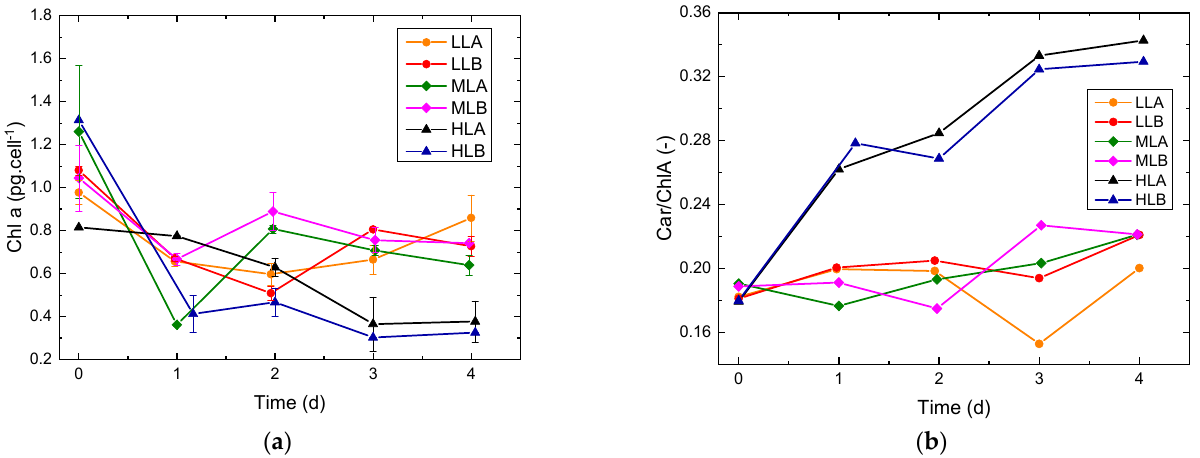
Figure 5. Evolution of pigment content over time. Error bars are the standard deviations between duplicates. ( a ) Chl a content per cell. The average standard deviation is about 0.06 pg·cells − 1 , however in some samples the error is higher, up to 0.12–0.15 pg·cells − 1 . ( b ) Carotenoids/Chl a ratio over time.